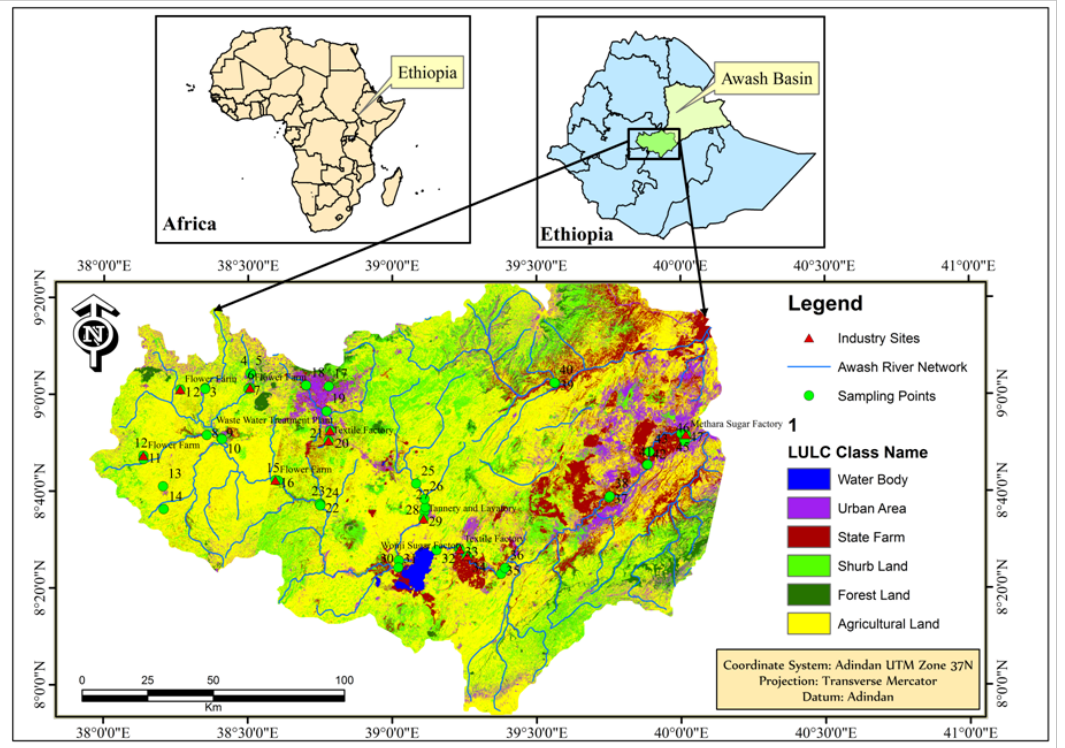
Figure 1. Map of the study area and the specific sampling sites.